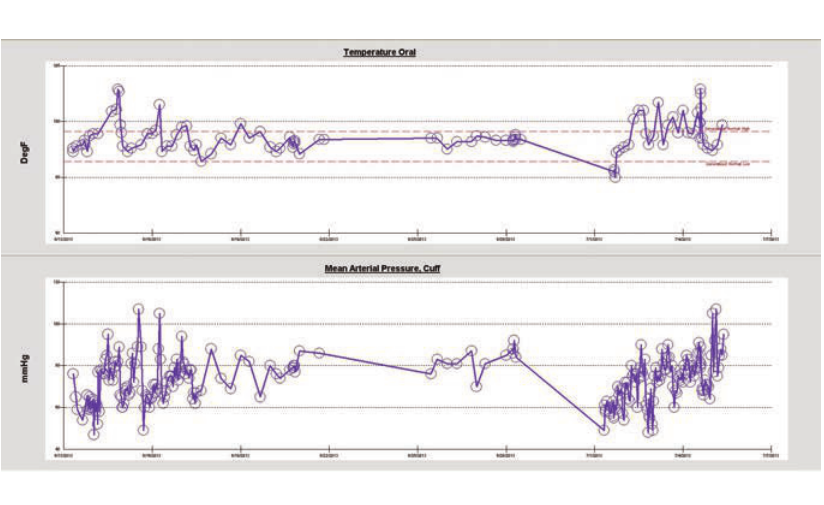
Figure 3. Graphs of the blood pressure and temperature curves of this patient during first and second admission